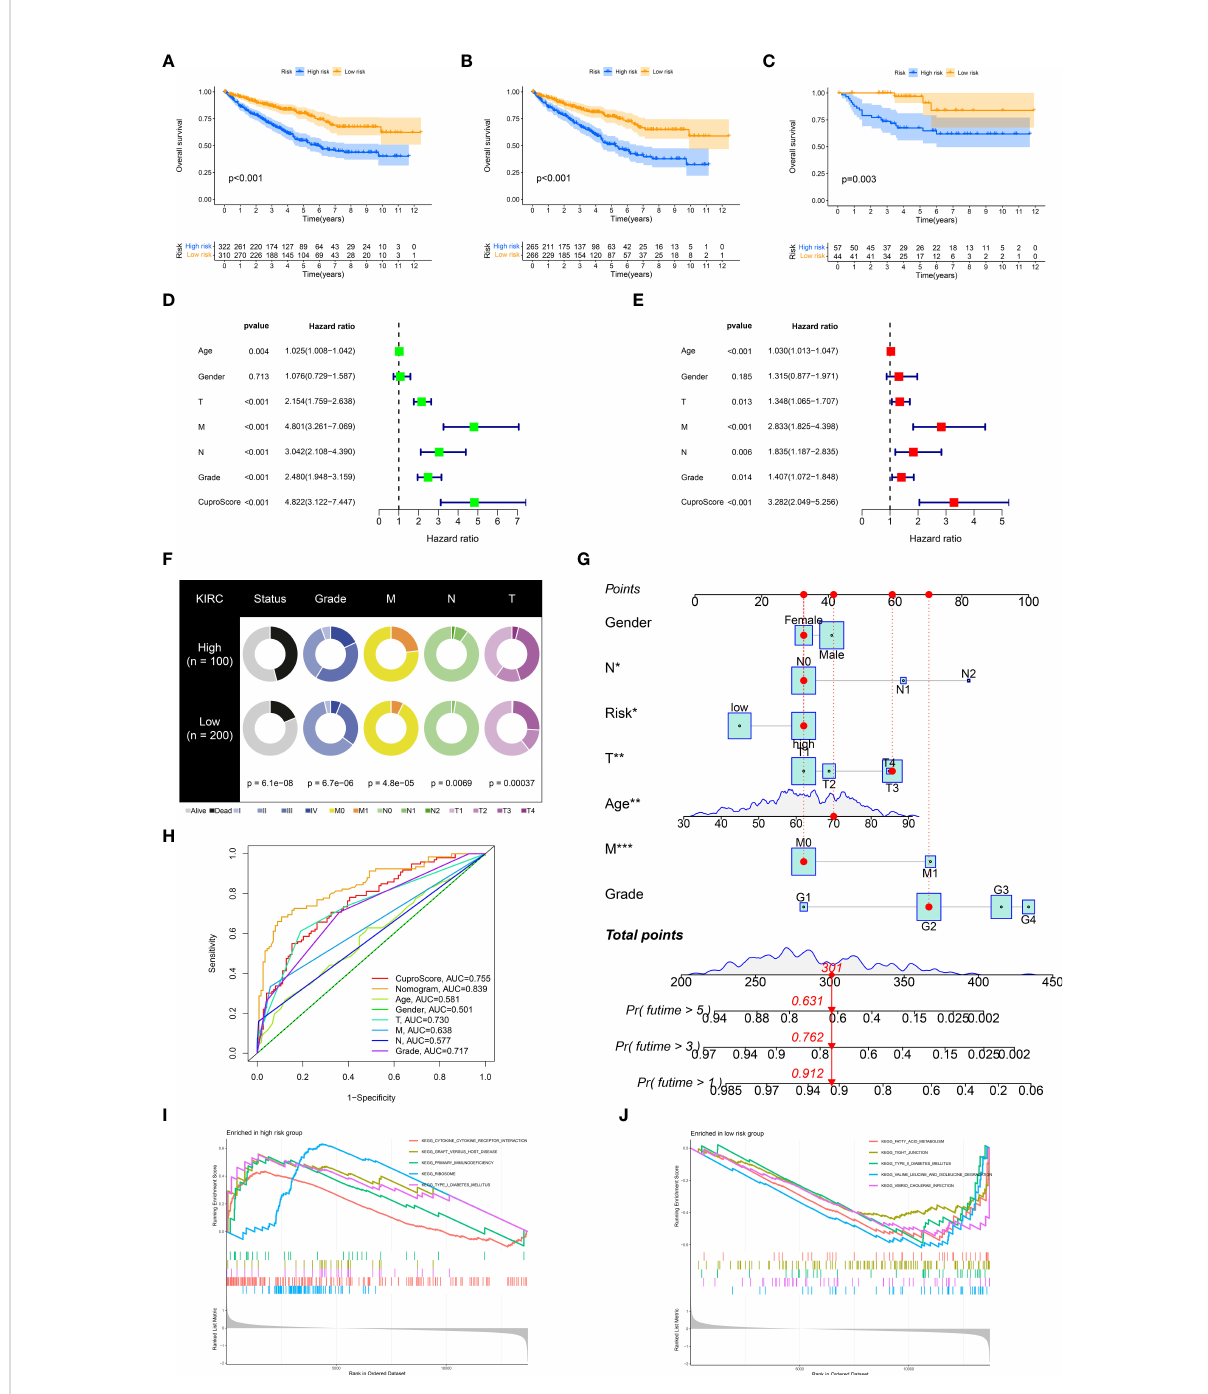
FIGURE 4 Clinical relevance and biological characteristics of CuproScore. Kaplan-Meier Curves for differential survival of two risk groups in the KIRC cohort (A) , TCGA (B) , and E-MTAB-1980 (C) cohort. Univariate (D) and multivariate (E) Cox regressions con fi rm CuproScore as an independent prognostic factor. (F) Clinical characteristics of the high and low scoring groups. (G) A nomogram for predicting the 1 year, 3 years, and 5 years survival rates of patients. (H) ROC curves for different risk factors. KEGG pathway enrichment analysis in the high-risk group (I) and low-risk group (J) . * P < 0.05, ** P < 0.01, *** P <